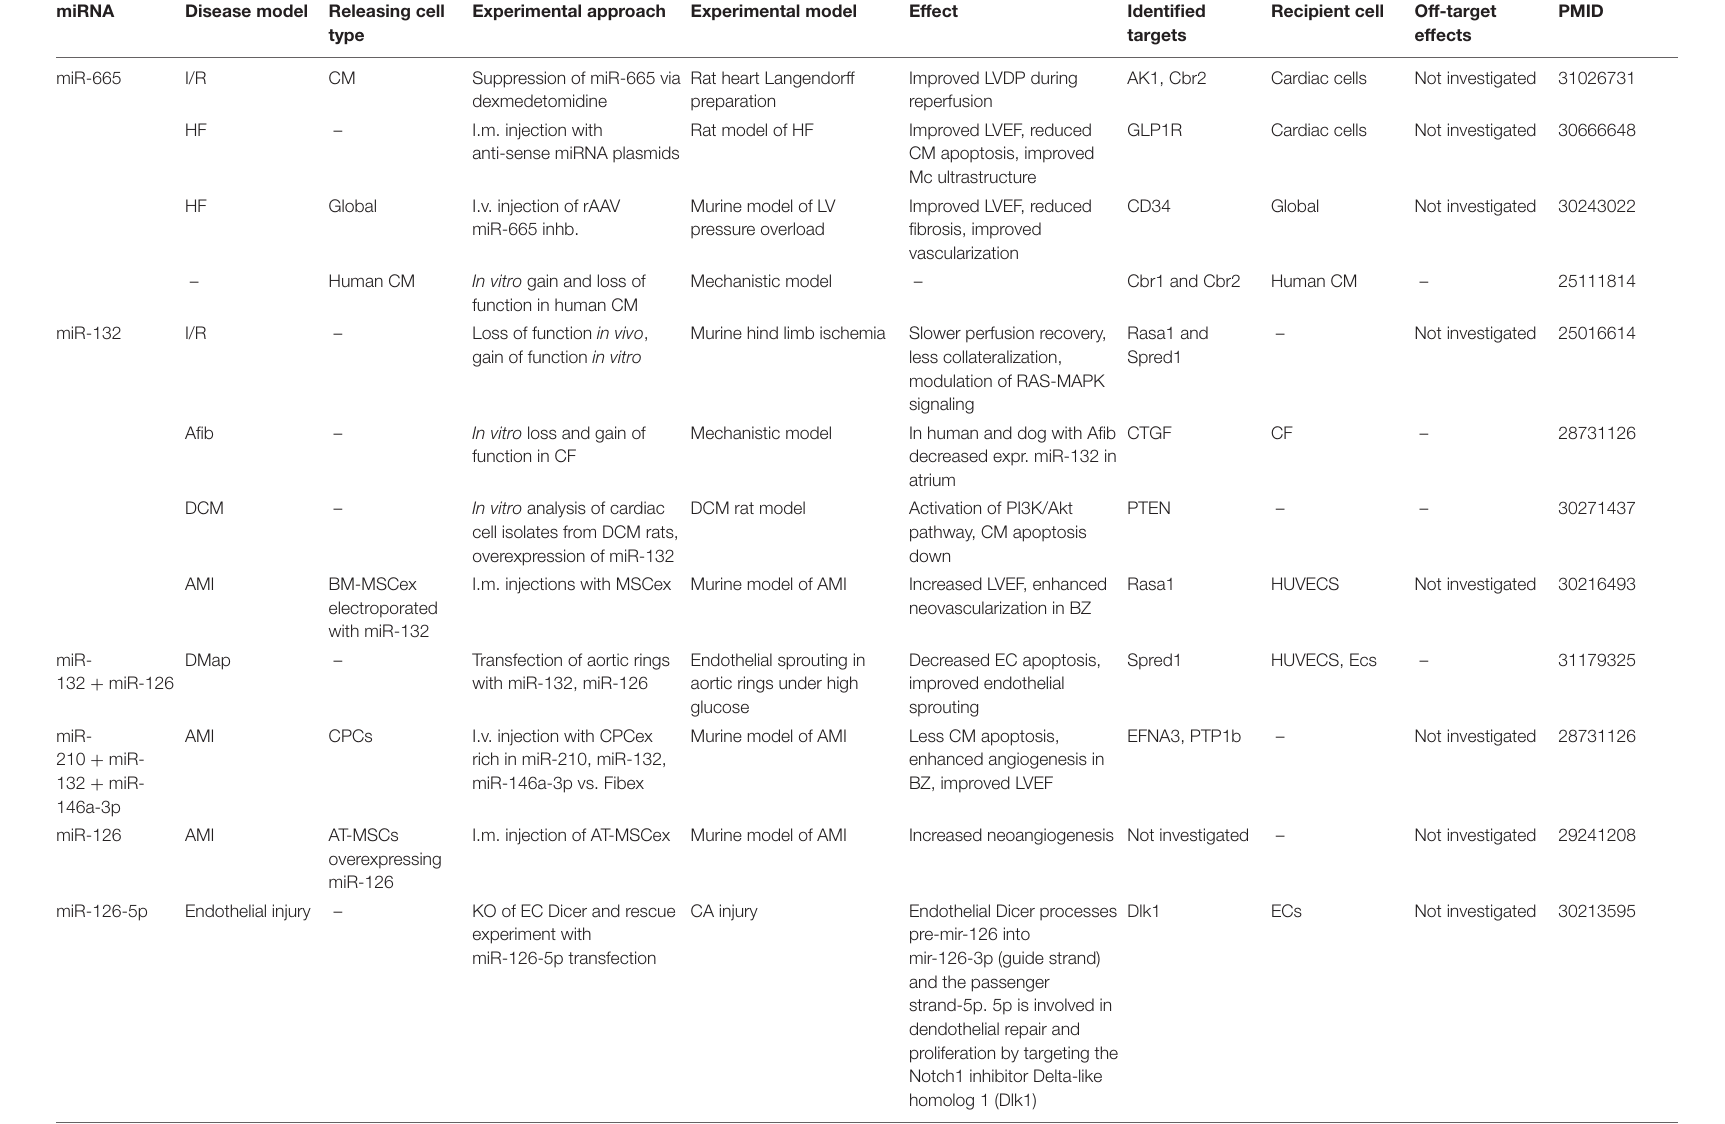
TABLE 1 | Summarizes a selection of miRNAs that have been identified with either a harmful or cardioprotective property in cardiovascular disease.